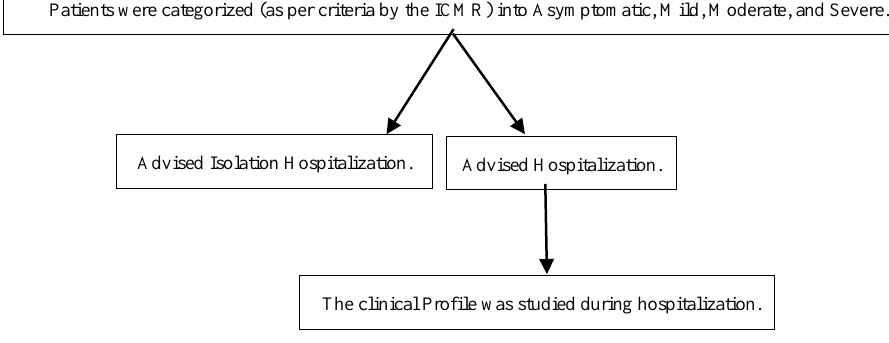
Fig. 1. Study algorithm.